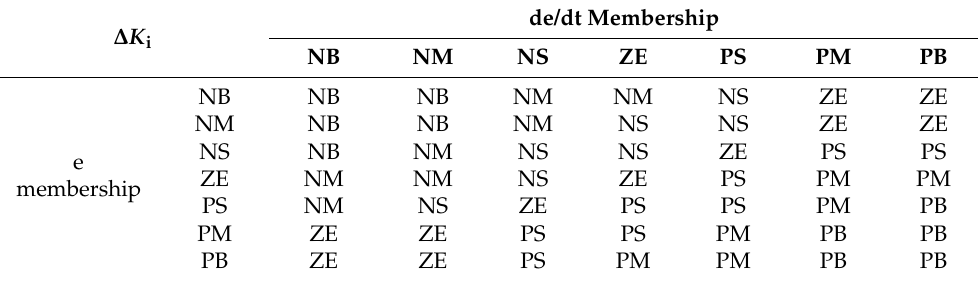
Table 2. ∆ K i fuzzy rule